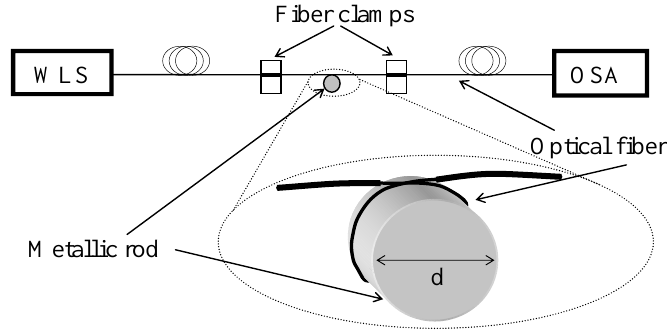
Figure 2. Schematic representation of the experimental set-up. WLS and OSA stand for white light source and optical spectrum analyzer,